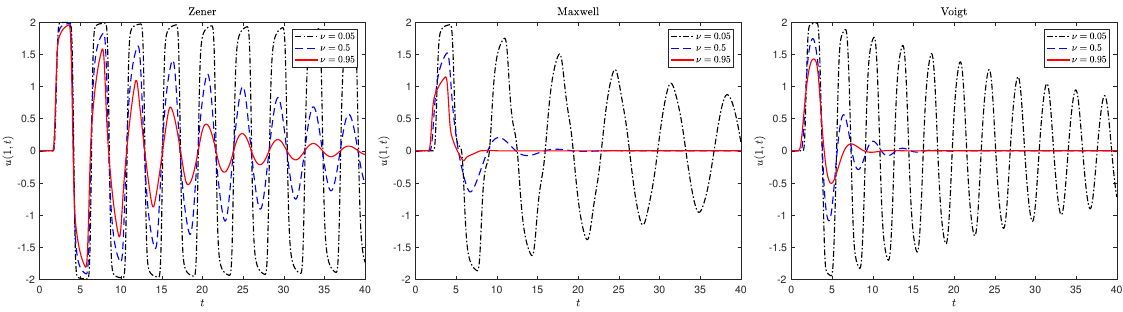
Fig. 3 Effect of changing ν using the parameters given in Table